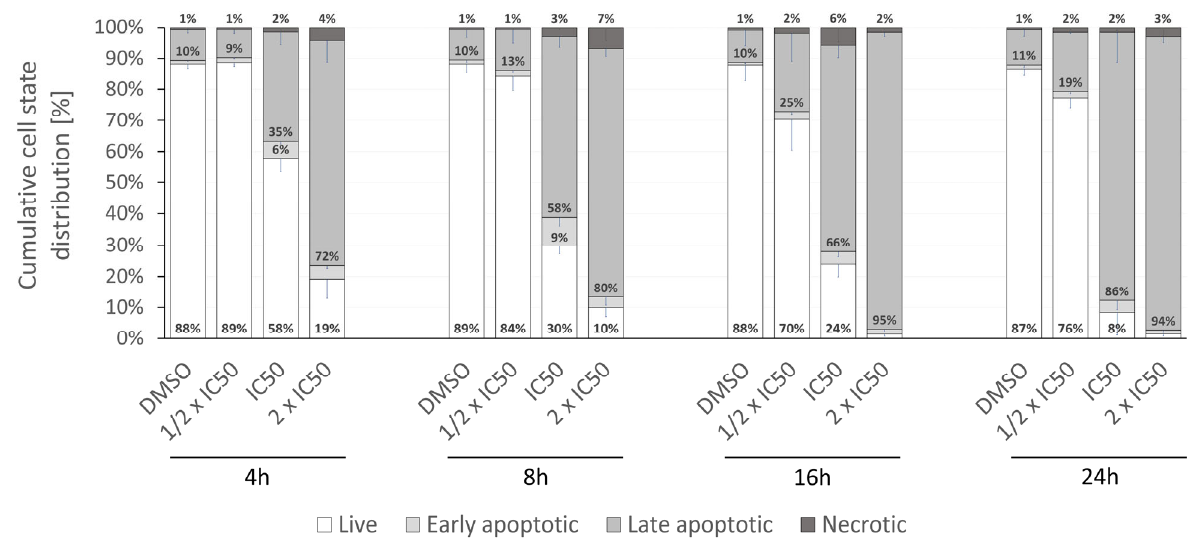
Figure 11. Detailed cell state distribution after HeLa cells exposure to rinderol. Time and dose- dependent shift toward apoptotic cell death are demonstrated and expressed as a percent of HeLa cells (live, early apoptotic, late apoptotic, or necrotic) after exposure to the studied compound. Presented data are the means ± SD of at least three independent replicates. HeLa cells were treated with rinderol in respective concentrations: 1/2 IC 50 –2.83 µ g/mL, IC 50 –5.66 µ g/mL, 2 × IC 50 –11.32 µ g/mL, DMSO–0.4%.